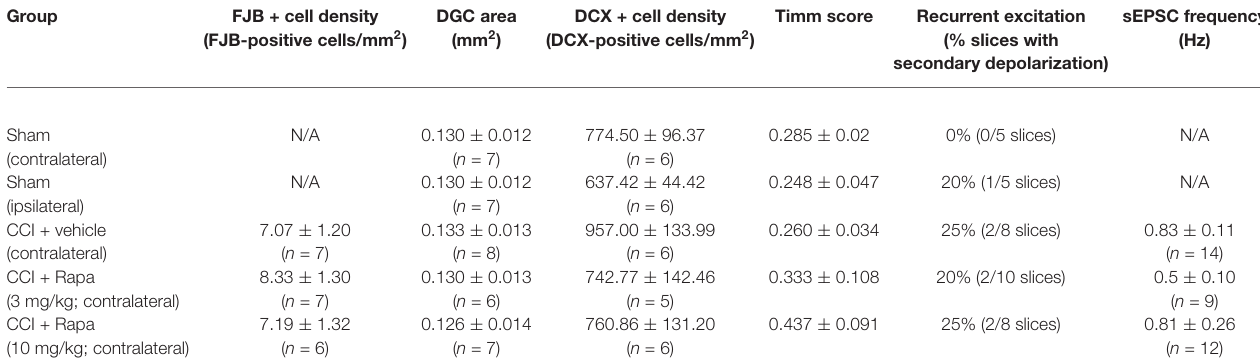
TABLE 1 | Measures from sham-operated mice (both hemispheres) and the hemisphere contralateral to injury after CCI in mice treated with vehicle or rapamycin.